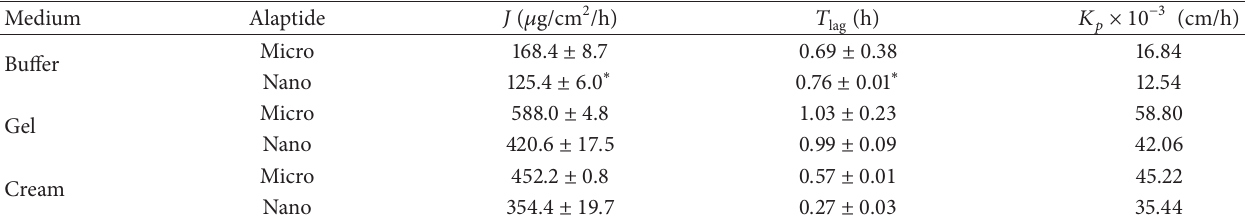
), and apparent permeability coefficient ( 𝐾 𝑝 lag